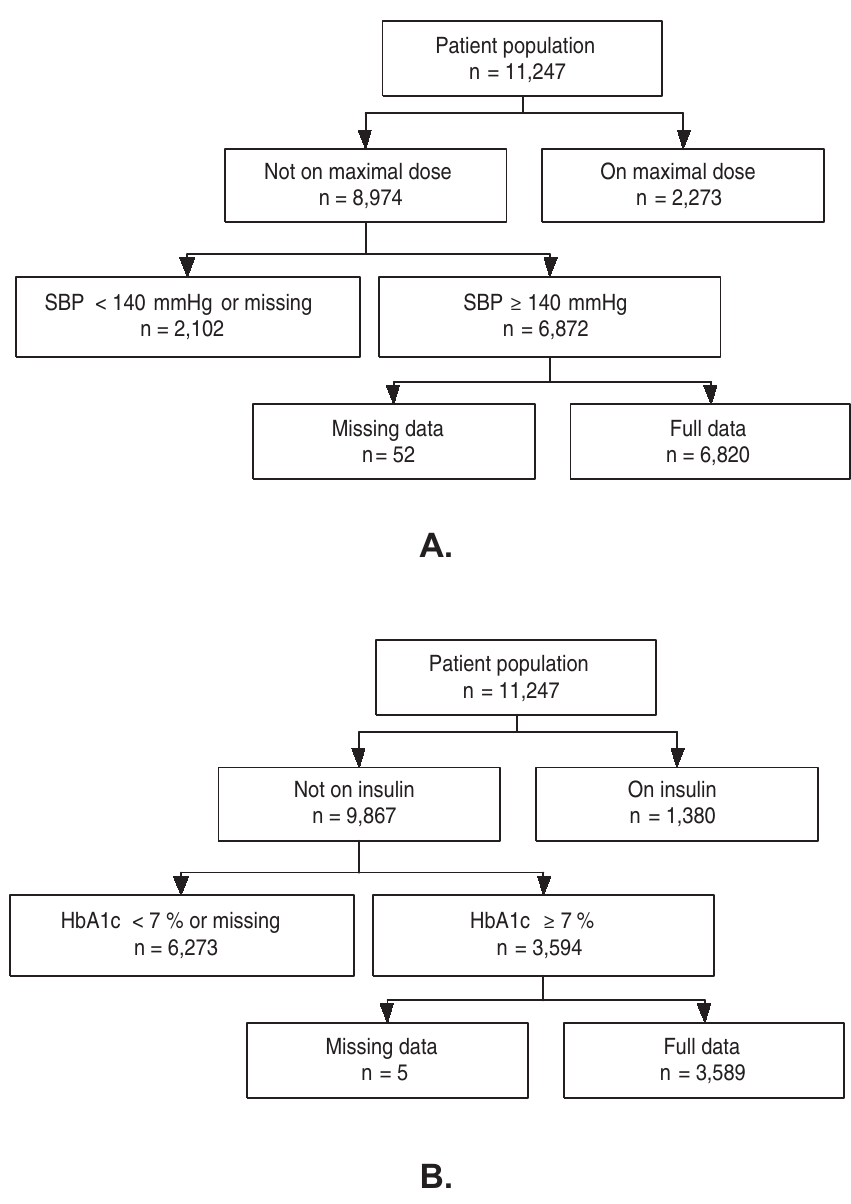
Figure 1. Patient selection for hypertensive (A) and hyperglycemia (B) study cohort.